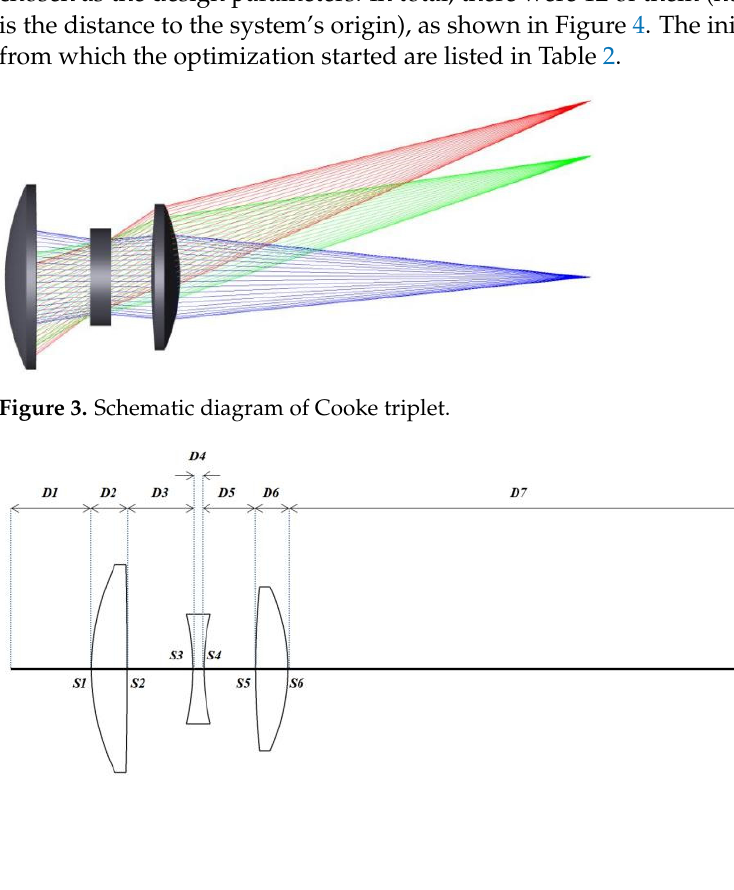
Figure 4. Schematic diagram of the design parameters of Cooke triplet (D for distance, S for radius of curvature). Table 2. Initial design parameters of Cooke triplet (Case 1). Parameter